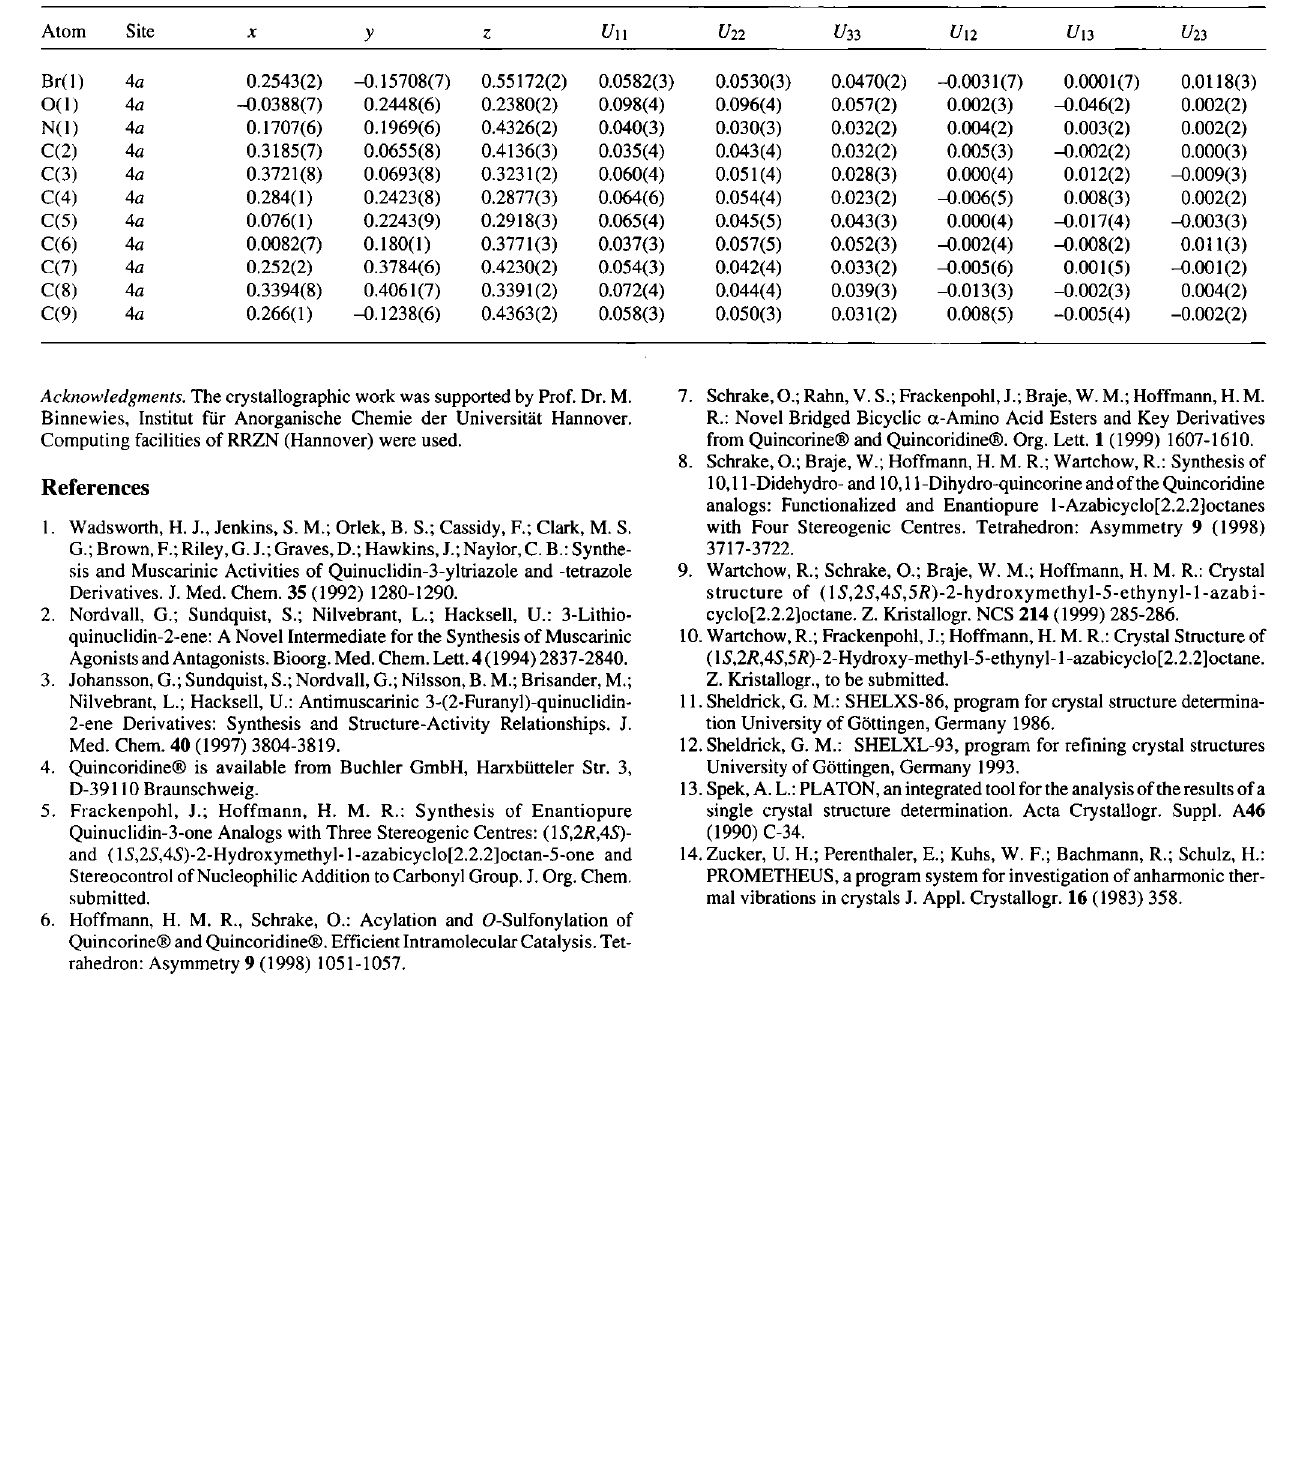
Table 3. Atomic coordinates and displacement parameters (in Ä 2